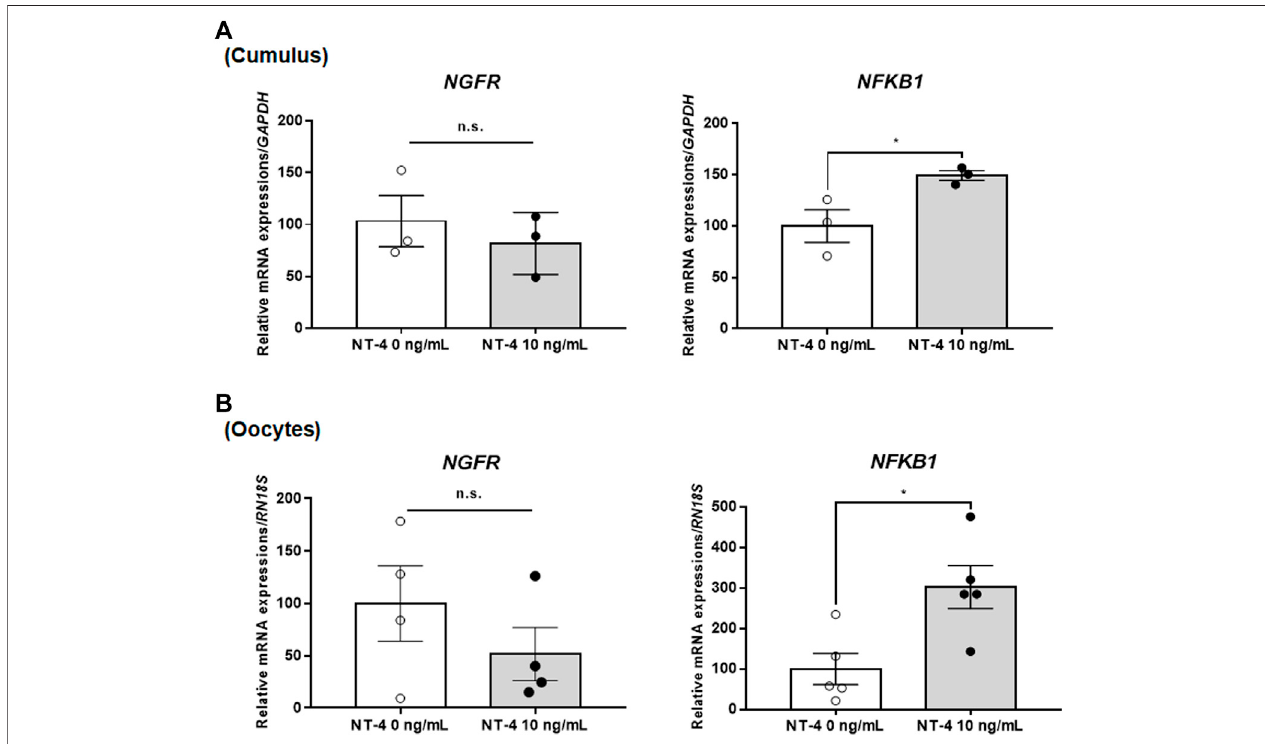
FIGURE 2 | Relative mRNA expression levels of low-af fi nity pan-neurotrophin receptor (p75 NTR )-related genes in neurotrophin-4 (NT-4)-treated porcine cumulus cells (CCs) (A) and oocytes (B) . Values represent the mean ± SEM. * p < 0.05 (Student ’ s t-test). The experiment was replicated at least three times. n.s. indicates not signi fi cant (p >